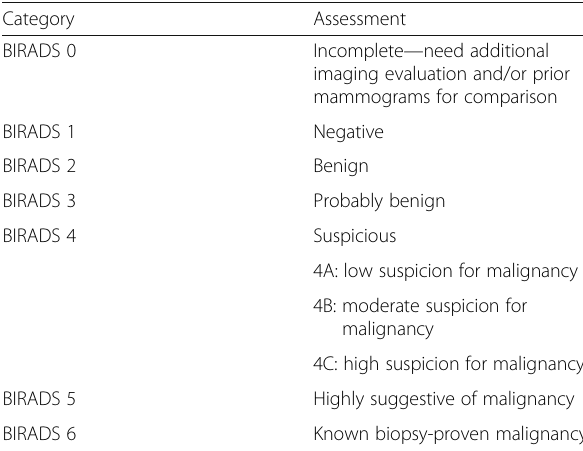
Table 1 BIRADS assessment categories according to BIRADS atlas 2013